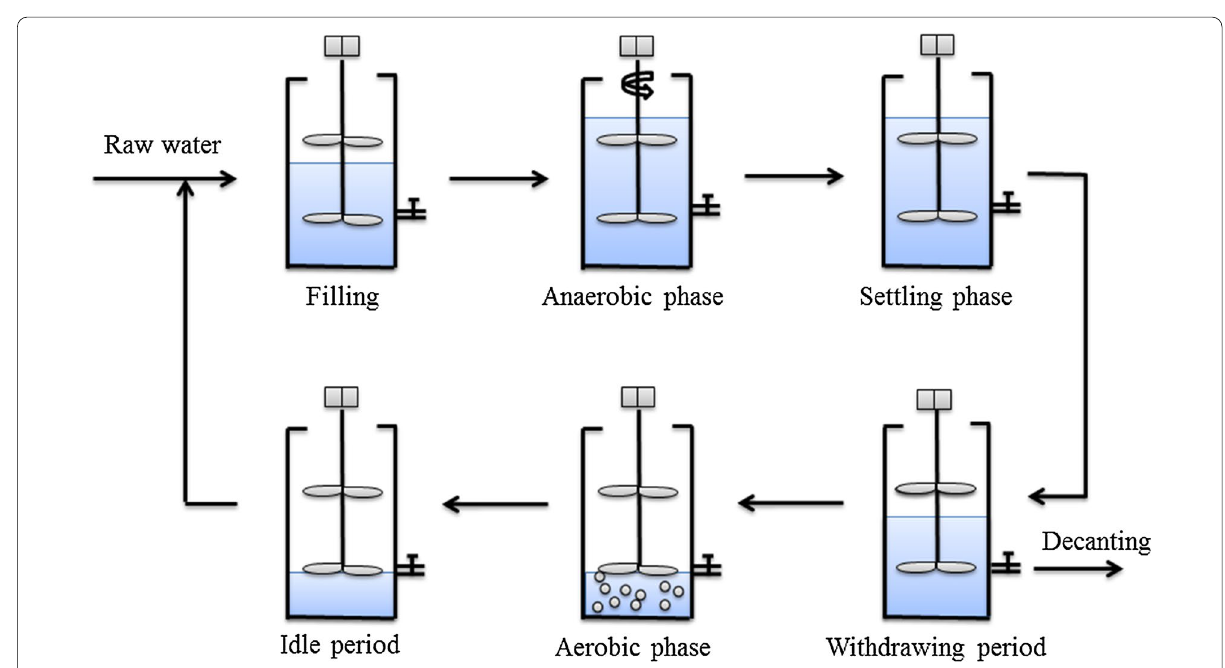
Fig. 1 Schematic diagrams of SBR